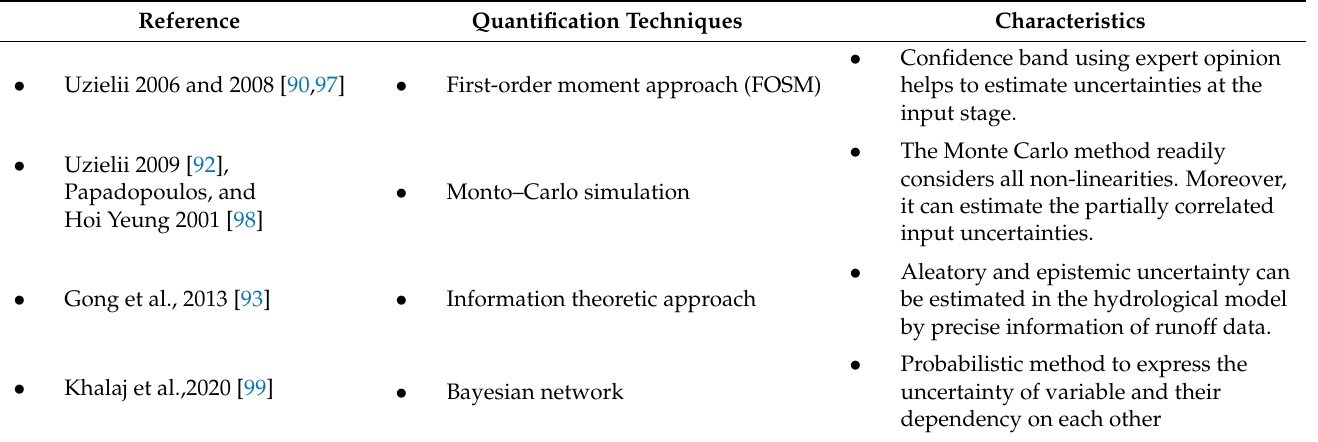
Table 3. Uncertainty quantification techniques in quantitative vulnerability